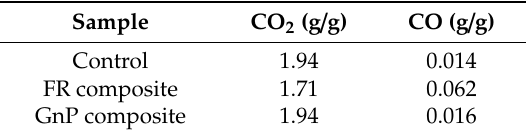
the flaming phase of the